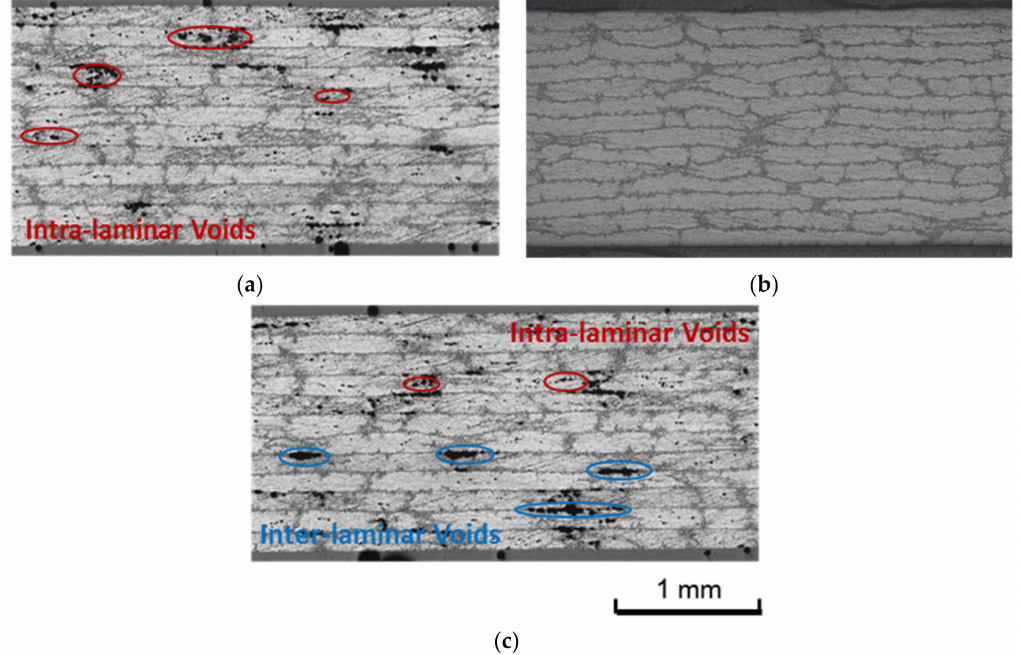
Figure 6. Optical micrographs for laminates cured with various initial cure temperature: ( a ) dwelling